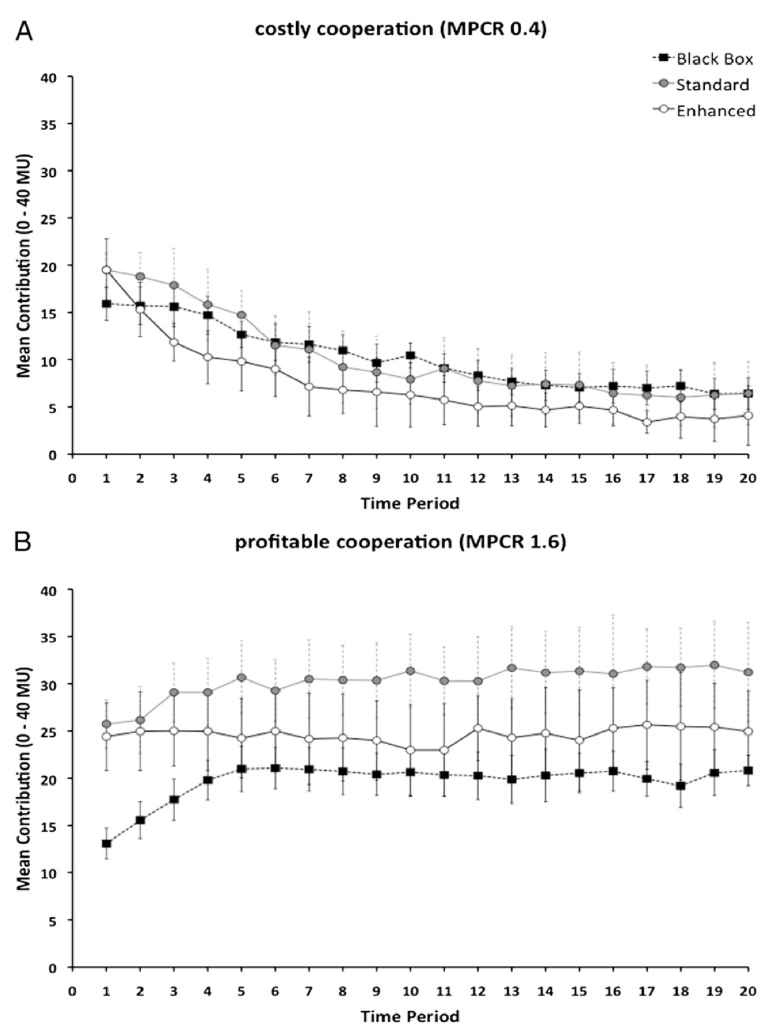
Figure 3. Results of the experimental study by Burton-Chellew and West; we refer the reader to [6] for more detailed